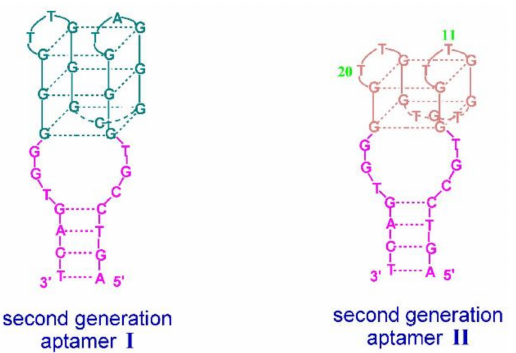
Figure 7. Schematic structure of quadruplex–duplex junctions with peroxidase-like activity [58]. Reproduced under the Creative Commons Attribution